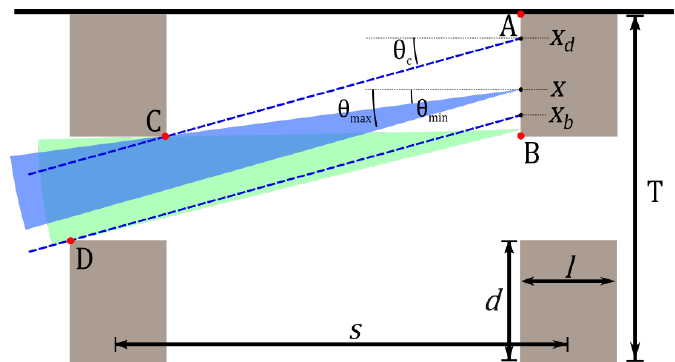
Figure 9. The meridional picture of the two-cavity design. A point x on the surface A-B is reachable through an aperture, presented by the left-most cavity. Light rays with polar angles in the sector bounded by θ min and θ max are able to reach and excite the point, as well as be emitted from the point and make it to the detector. The angles θ min and θ max must be smaller than or equal to the maximum polar angle of θ c . A ray originating from between Point B and the point x b will have its maximum angle constrained by Point